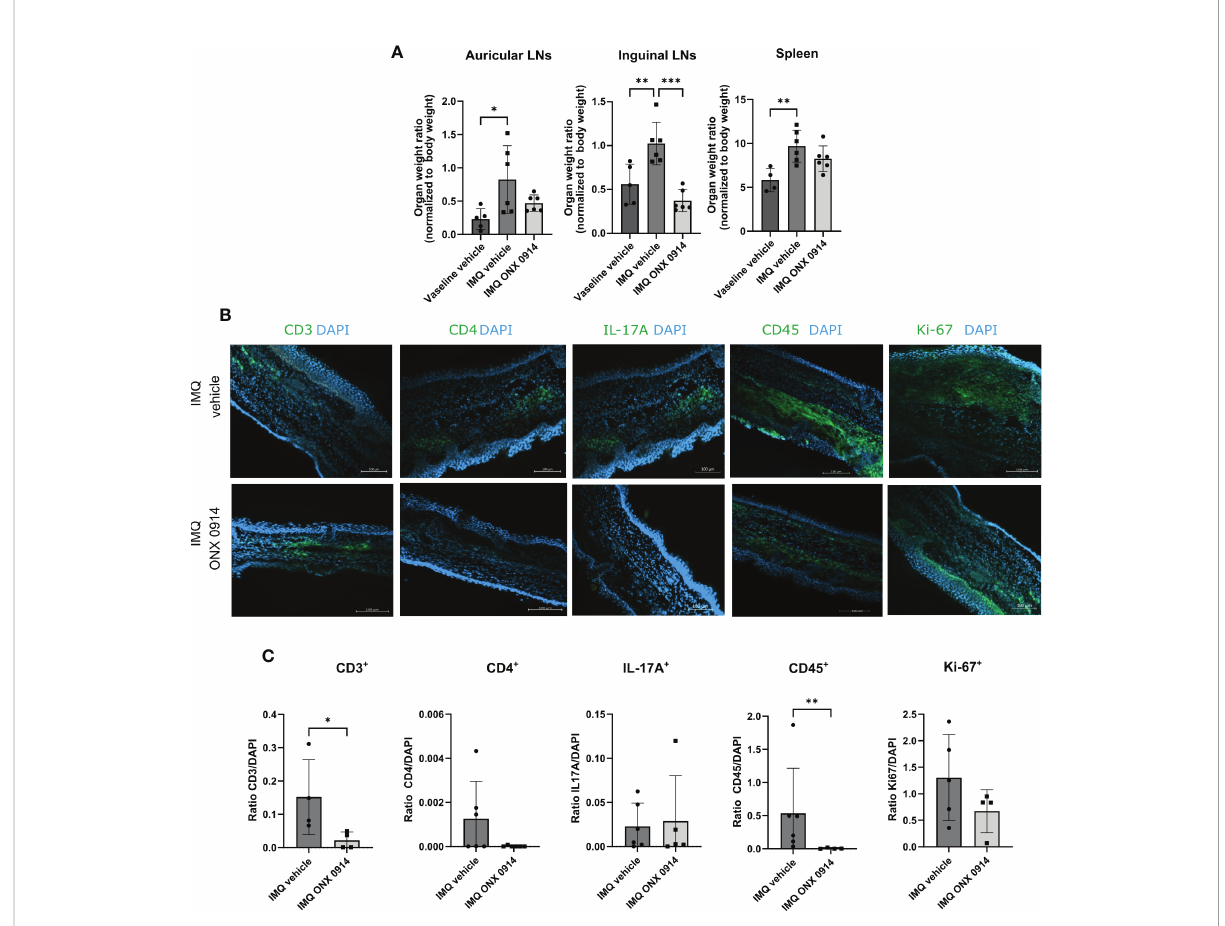
FIGURE 6 Immunoproteasome inhibition normalizes the weight of dLNs and ameliorates the in fl ammatory in fi ltrate in IMQ-induced psoriasis-like in fl ammation. IL-17A-GFP mice were treated as described in Figure 5A. (A) The dLNs and spleens were harvested after 8 days of treatment with IMQ/vaseline. On the g -axis, the organ weight normalized to the body weight is depicted. Data (vaseline vehicle n = 4-5, IMQ vehicle, and ONX 0914 n = 6) was pooled from two independent experiments and analyzed by a one-way ANOVA followed by a S ̌ ida ́ k test. (B) Representative images of ear cryosections that were stained with anti-CD3, anti-CD4, anti-CD45, anti-Ki67 antibodies or IL-17A (all in green), and DAPI (in blue). The scale bar is 100 m m (C) The positive signal was quanti fi ed with ImageJ. On the g -axis, the ratio of the fl uorescence signal to DAPI is depicted. Data (n = 4-6) were pooled from 2 independent experiments and statistically analyzed by unpaired t-test or Mann-Whitney test. All values represent mean ± SD. * p < 0.05, ** p <0.01, and *** p <